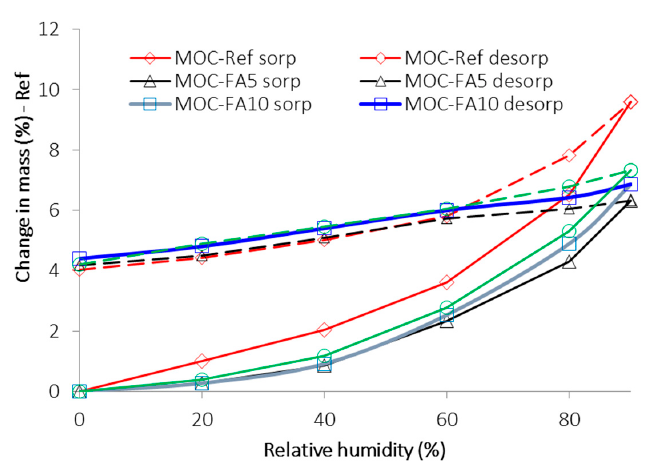
Figure 6. Sorption and desorption isotherms.